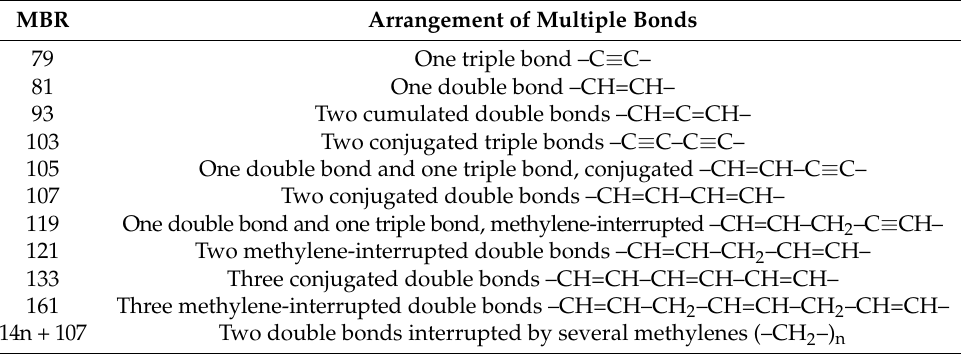
Table 1. Multiple bond region (MBR) values for common arrangements of double bonds (DBs) and triple bonds (TBs) in polyunsaturated